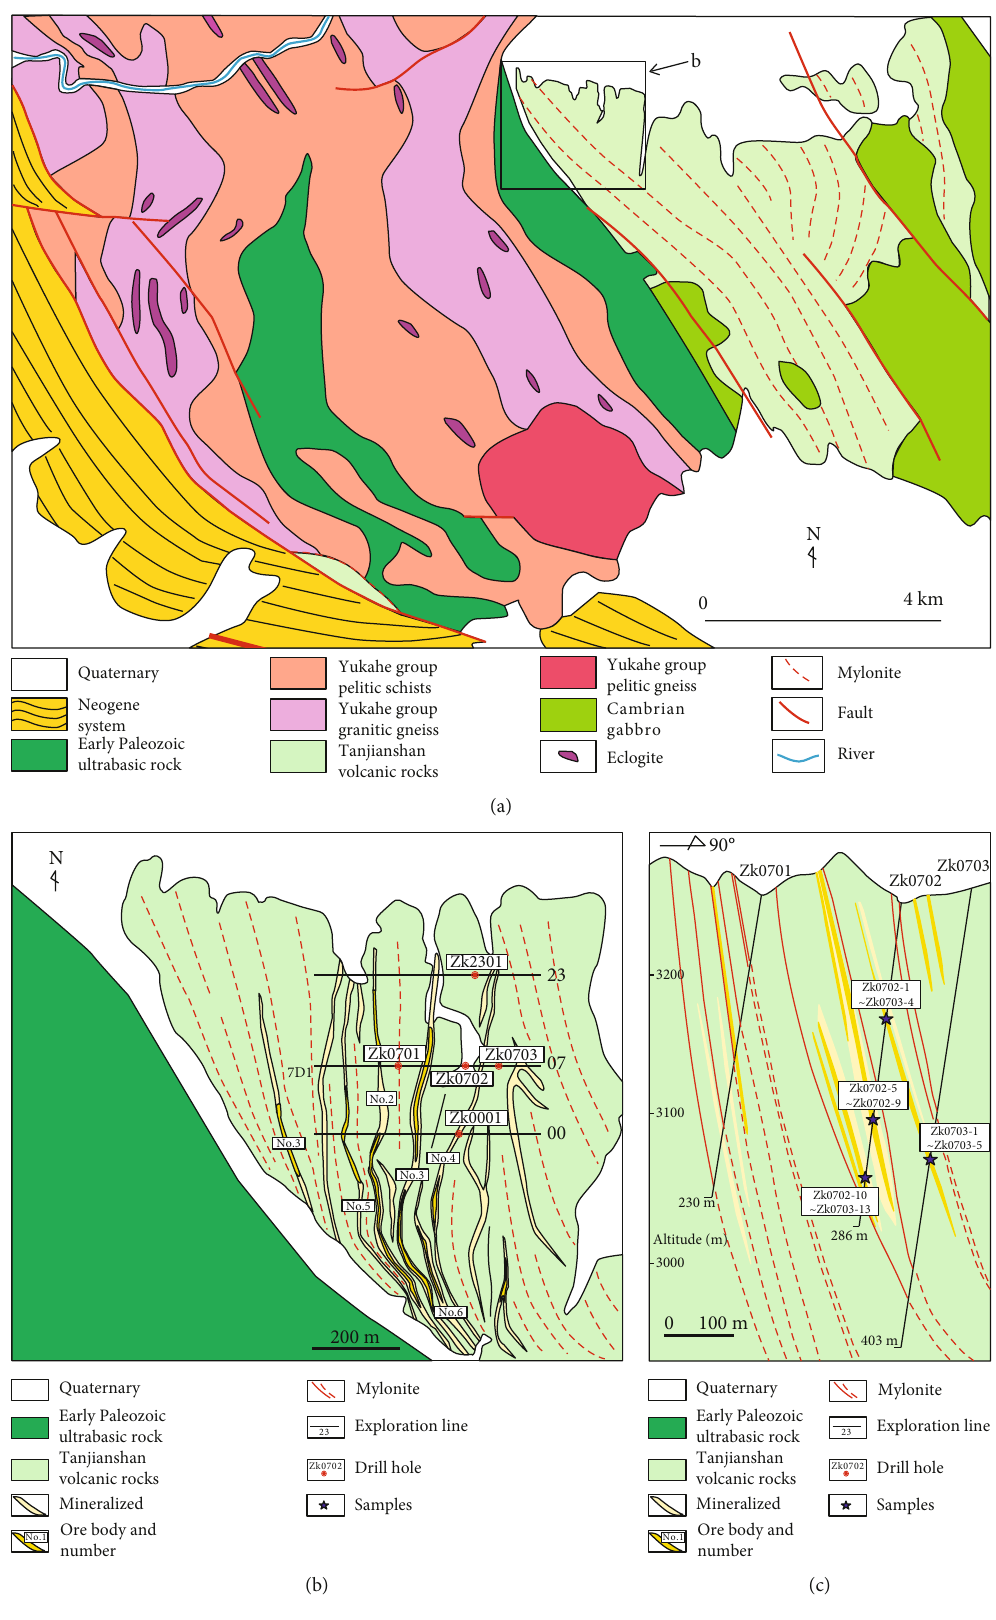
Figure 3: (a) Regional geological map of the Yuka district; (b) geology and distribution of the Yuka gold deposit; (c) geological section along the 07 exploration line of Yuka gold